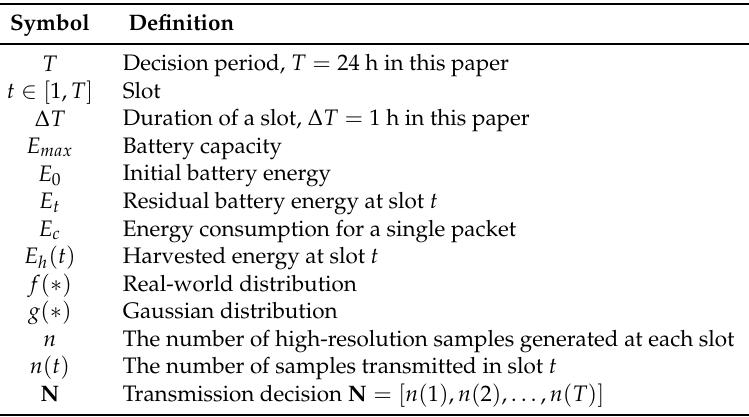
Table 1. Notations used in this